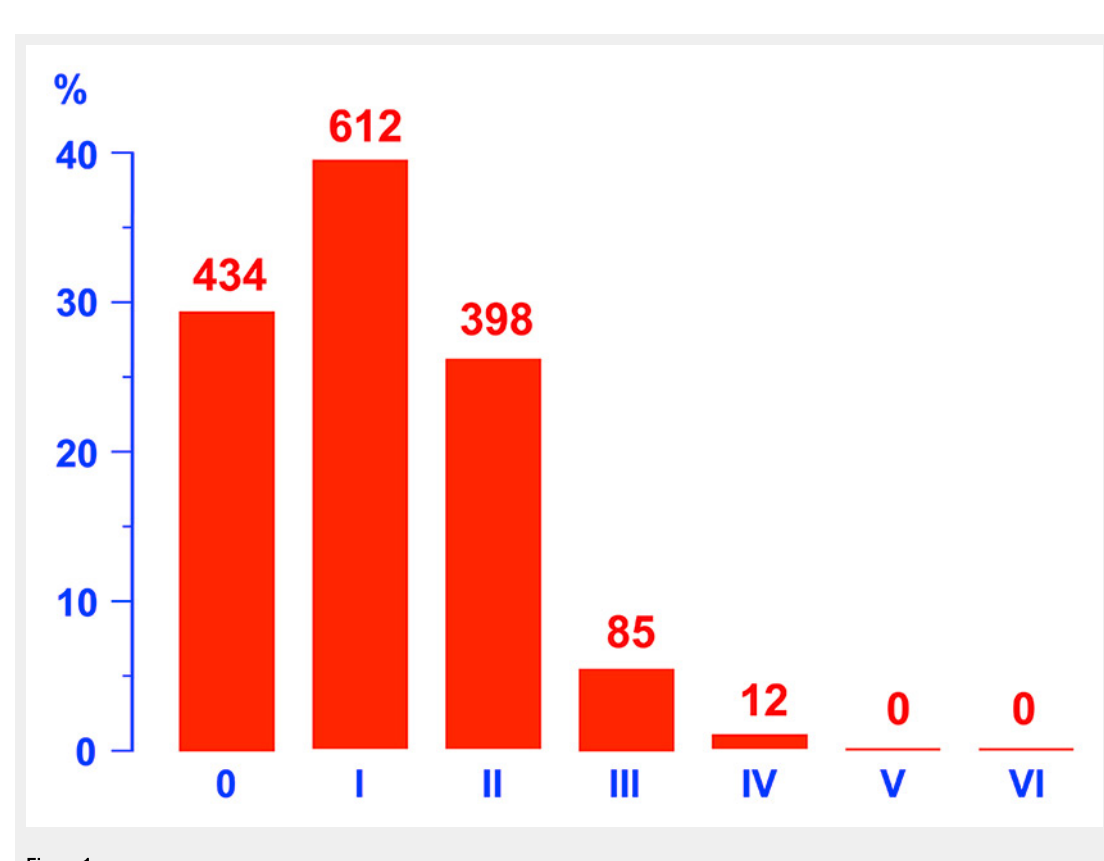
Figure 1 Clustering of cardiovascular risk factors (positive cardiovascular family history; smoker status; sedentary lifestyle; increased waist circumference; arterial hypertension; increased total cholesterol level) in 1541 ostensibly healthy male citizens undergoing a compulsory medical examination between 2009 and 2013 to assess fitness for recruitment into the Swiss army in the year they turn 18 to